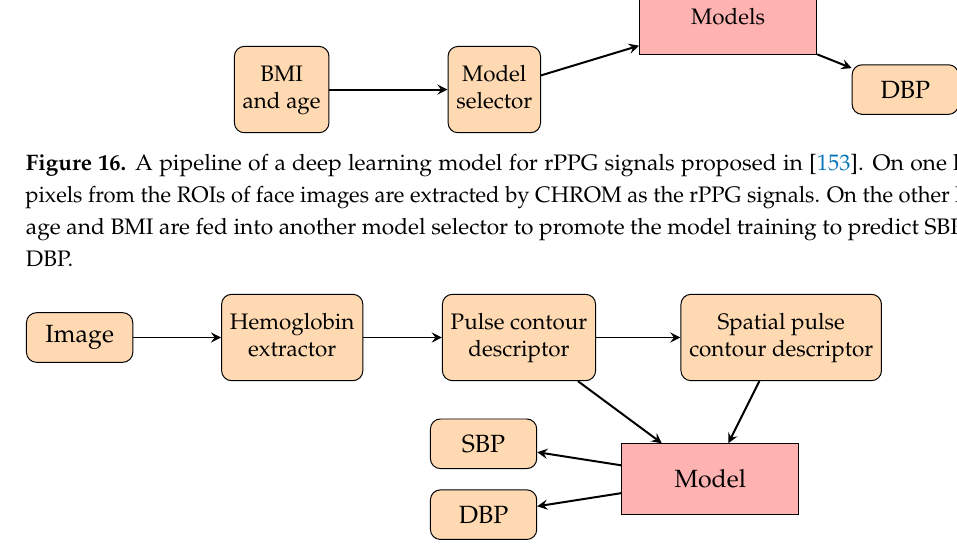
Figure 17. A pipeline of a deep learning model for rPPG signals proposed in [232]. Pixels from RGB face images are extracted to form intensity maps of melanin, hemoglobin (Hem), and shading (residual information). Those extracted signals are used for constructing the pulse contour descriptor, which does not include spatial information, and the spatial pulse contour descriptor, which includes spatial details, in order to preserve spatial phase relationship of the rPPG signals. Both descriptors are used as inputs for the model for prediction of SBP and